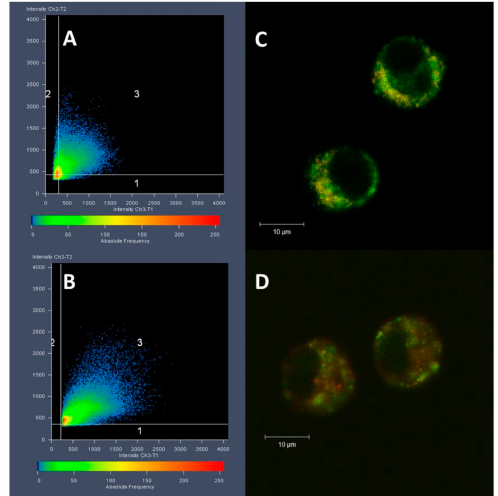
Figure 8. CLSM imaging and ROI analysis of PIPOx-FITC colocalization with organelles. ROI analysis in ( A ) mitochondria, R = 0.3 ± 0.1, and ( B ) lysosomes, R = 0.5 ± 0.16. Merged CLSM images of fluorescently labeled PIPOx-FITC (green) with ( C ) MitoTracker-labeled mitochondria (orange) or ( D ) LysoTracker-labeled lysosomes